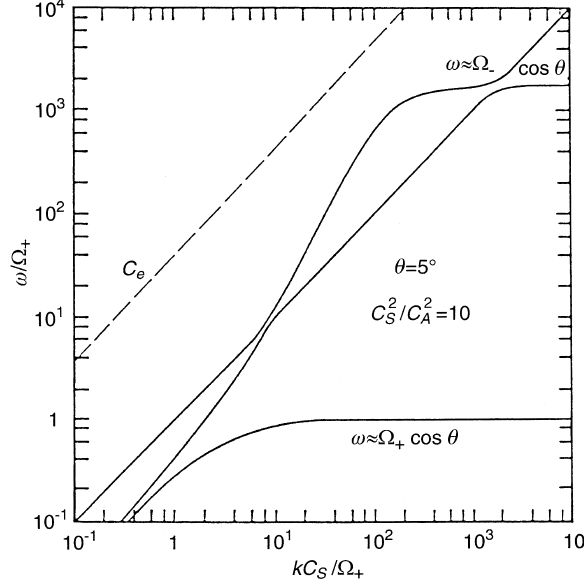
Fig. 9. Dispersion relations for 3 MHD modes from Formisano and Kennel, (1969) calculated for the case (cid:98)